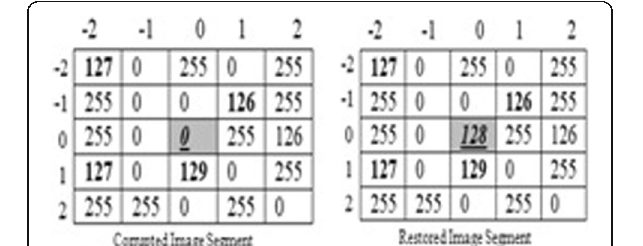
essed. The pixel position of 127 in the first row is these above said positions as calculated in d (1).